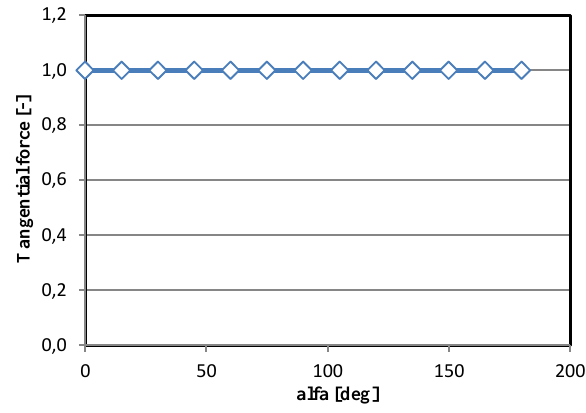
Fig. 9. A tangential force when a shaft turns from 0 to 180 degrees T = P; P = 1 – force acting on the piston (conventionally assumed equal to 1).